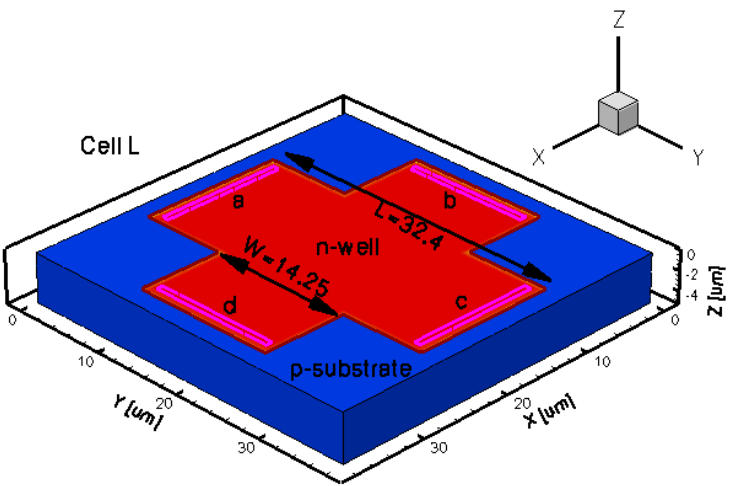
Figure 3. 3D representation of the L simulated Hall cell.